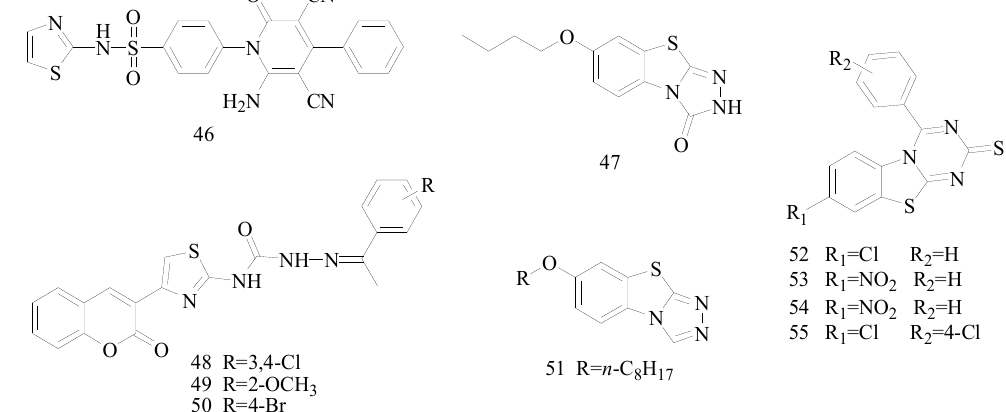
Figure 1. Structures of compounds 46 – 55 .